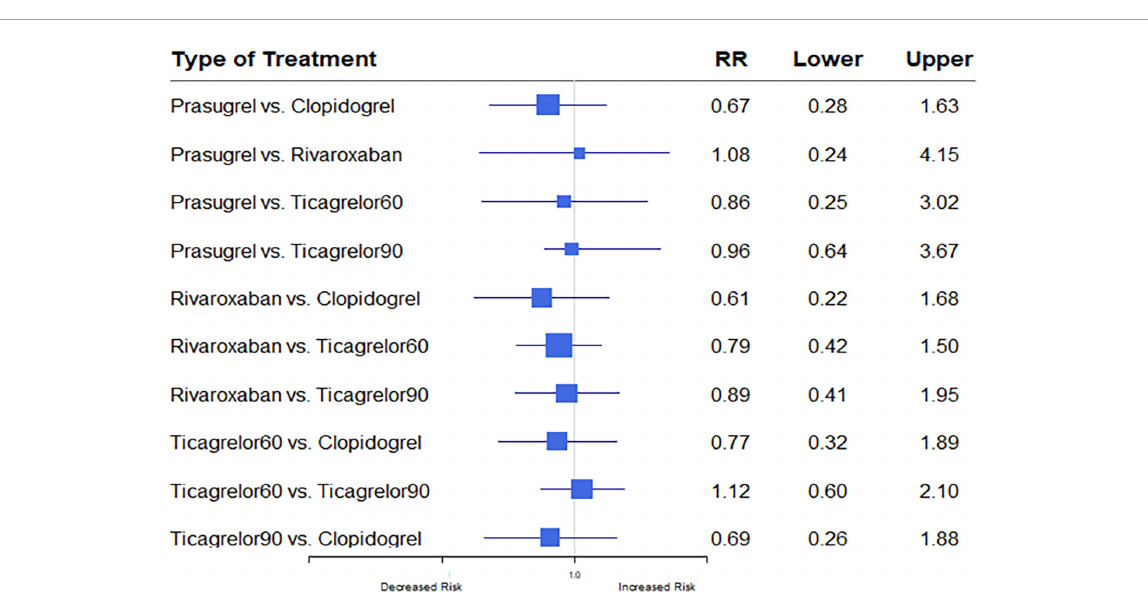
blinding of outcome assessment (8/11, 72%), and incomplete outcome data (9/11, 81%). A few studies were in the highest categories for risk of bias, regarding blinding of participants and personnel (4/11, 36%), and